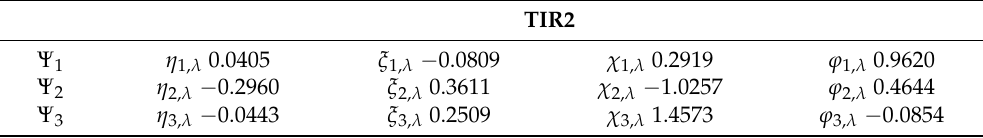
Table 3. Parameters to calculate Ψ 1 , Ψ 2 , and Ψ 3 through Landsat 8. TIR: Thermal Infrared.